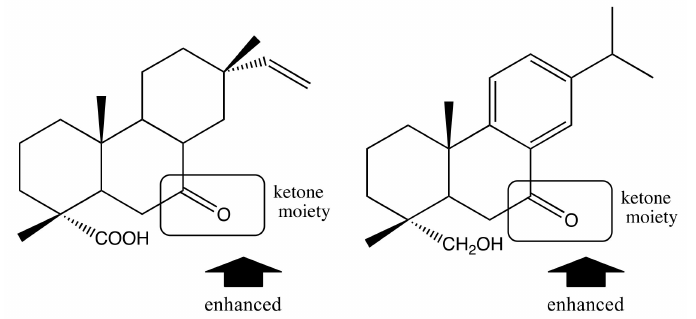
Figure 3. Structure–activity relationships of diterpenoids. Several of the isolated flavonoids ( 25 – 30 ) inhibited the proliferation of cell